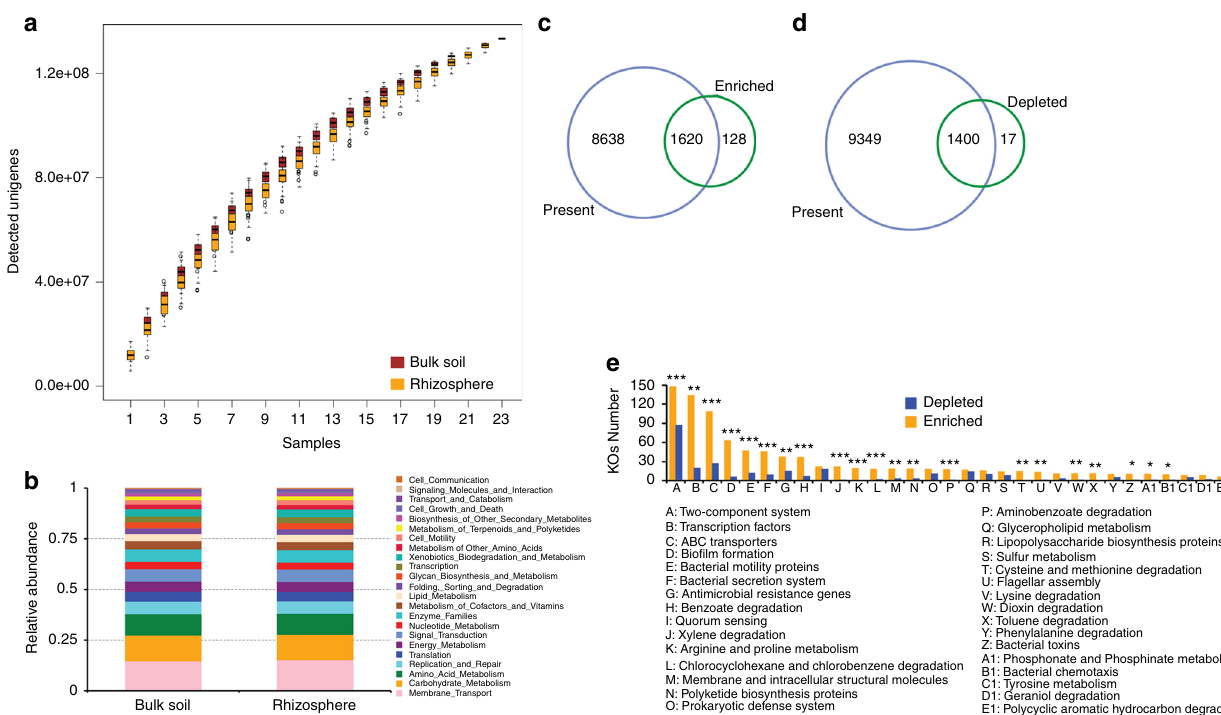
Fig. 4 Characterization of the core function of the citrus rhizosphere microbiome. a Rarefaction curve of detected genes in citrus rhizosphere and bulk soil microbiomes based on 100-fold permuted sampling orders, center value represents the median of detected genes. b Functional KEGG level 2 pathway comparison of citrus rhizosphere and bulk soil microbiomes. c Venn plot depicting the number of core rhizosphere KOs based on the presence rate (>75%) in all samples and the KO enrichment from bulk soil to rhizosphere. d Venn plot depicting the number of universal rhizosphere-depleted KOs based on the presence rate (>75%) in all samples and the depleted KOs from bulk soil to rhizosphere. e The distributions of the rhizosphere core KOs in the KEGG level 3 pathways; *corrected P -value<0.05; **corrected P -value<0.01; ***corrected P -value<0.001; Fisher ’ s exact test and P -value corrected by the BH